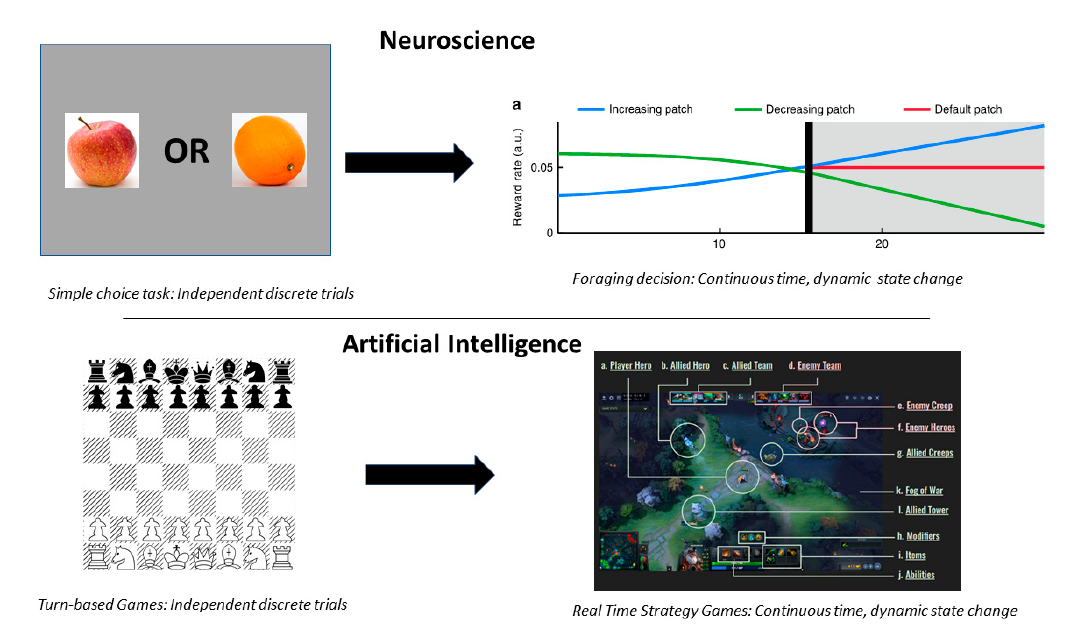
Figure 7. Transition from Independent Discrete Trials to Dynamic Continuous-Time Environments in both AI and Neuroscience. (Top) It has been historically assumed that the information processing in each trial during a neuroscience experiment is independent from information processing in other trials and that once one trial completes, all the information processing is reset. However, in the real world, events and decisions occur over continuous time frames and are often correlated with people’s choices being known to show temporal dependencies across multiple timescales. This has motivated a transition in neuroscience to continuous time experimental designs. (Bottom) A similar transition from spatially-temporally discrete turn-based games to continuous time and space real time strategy games is occurring in the field of AI research, such as from the ancient game of chess (Left) to the modern electronic real time strategy game Dota 2 (Right). Upper right image adapted with permission from Wittmann et al., Nature Communications, 2016; Nature Publishing Group [66]). Lower right image is taken from OpenAI [184], according to the license agreement.